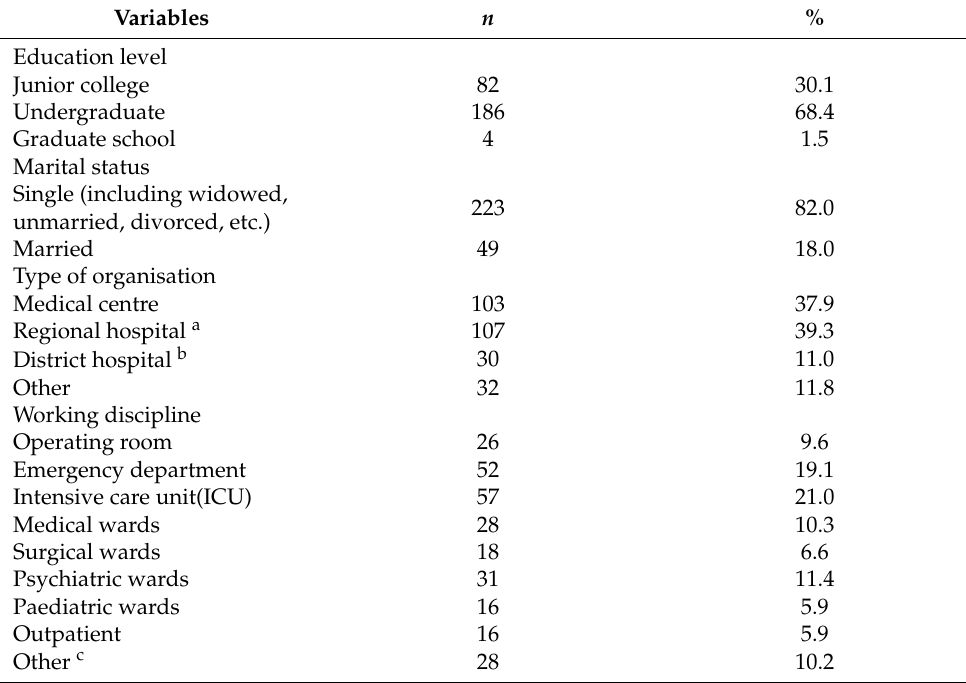
Table 1. Participant characteristics of newly graduated male nurses ( n =